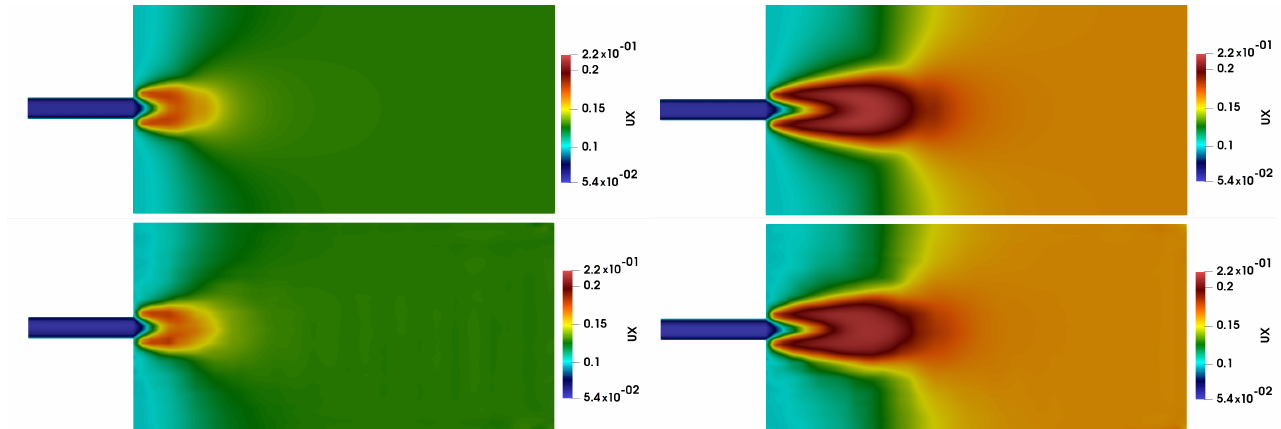
Figure 7. (Data-targeted VAE) On the top, the high-fidelity first component of the velocity fields for the two time steps 499 and 998. On the bottom, the decoder outputs for the two time steps 499 and 998 at the final 4000-th epoch of the training phase.